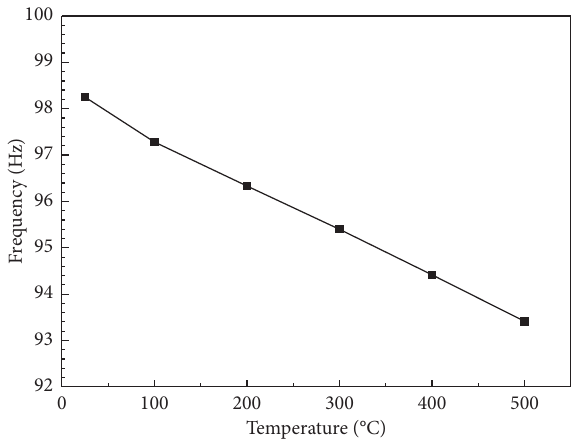
Figure 3: First-order natural frequency with temperature